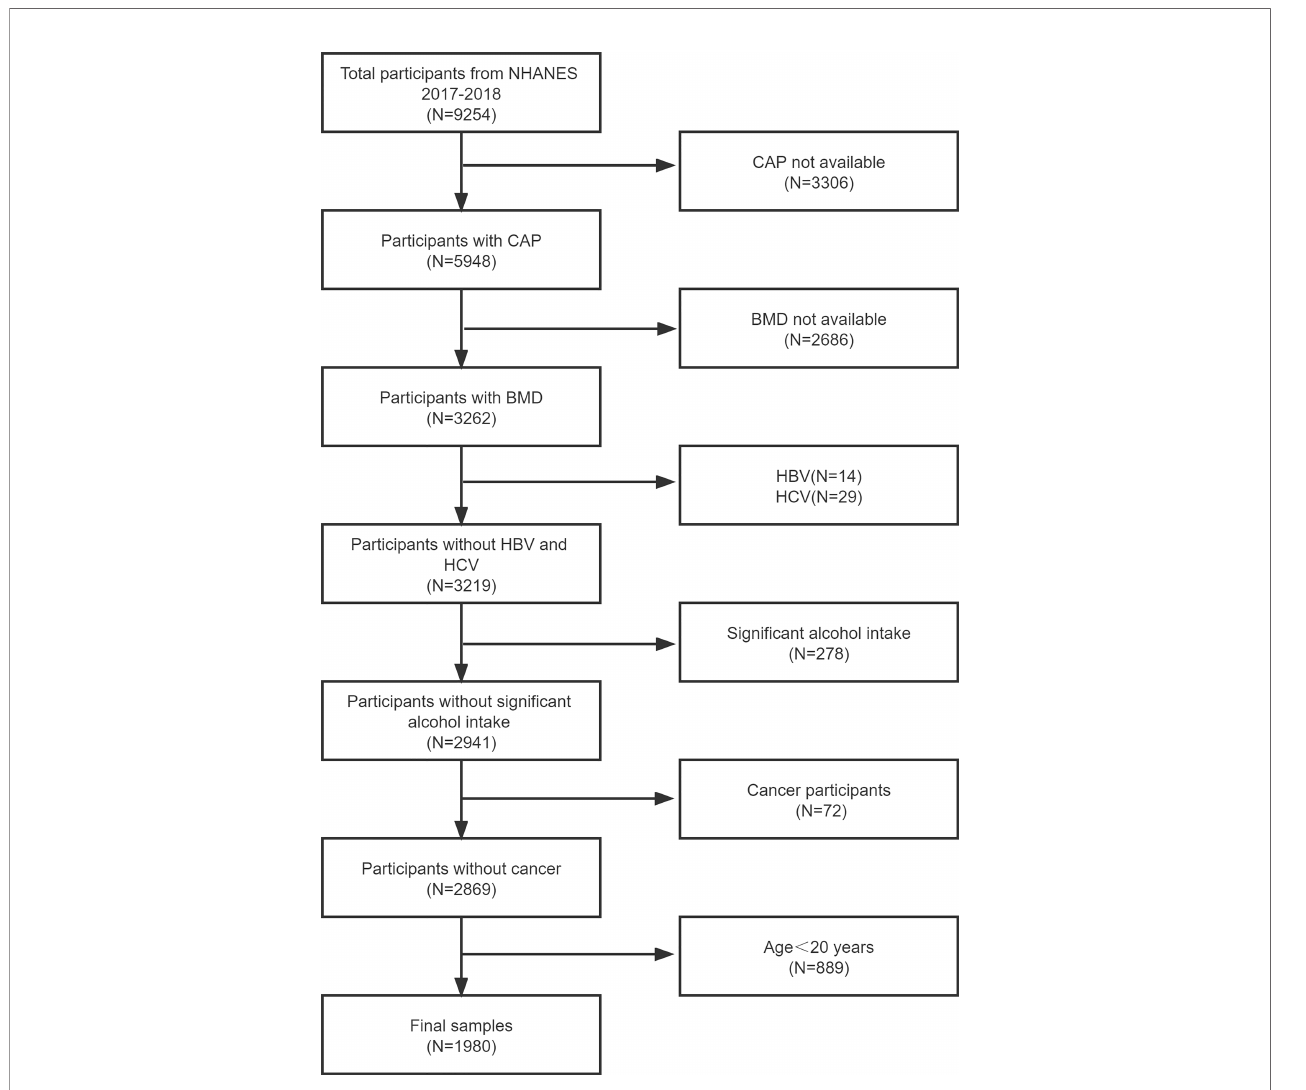
FIGURE 1 | Flow chart of participants selection. NHANES, National Health and Nutrition Examination Survey; CAP, controlled attenuation parameter; BMD, bone mineral density; hepatitis B virus, HBV; hepatitis C virus,